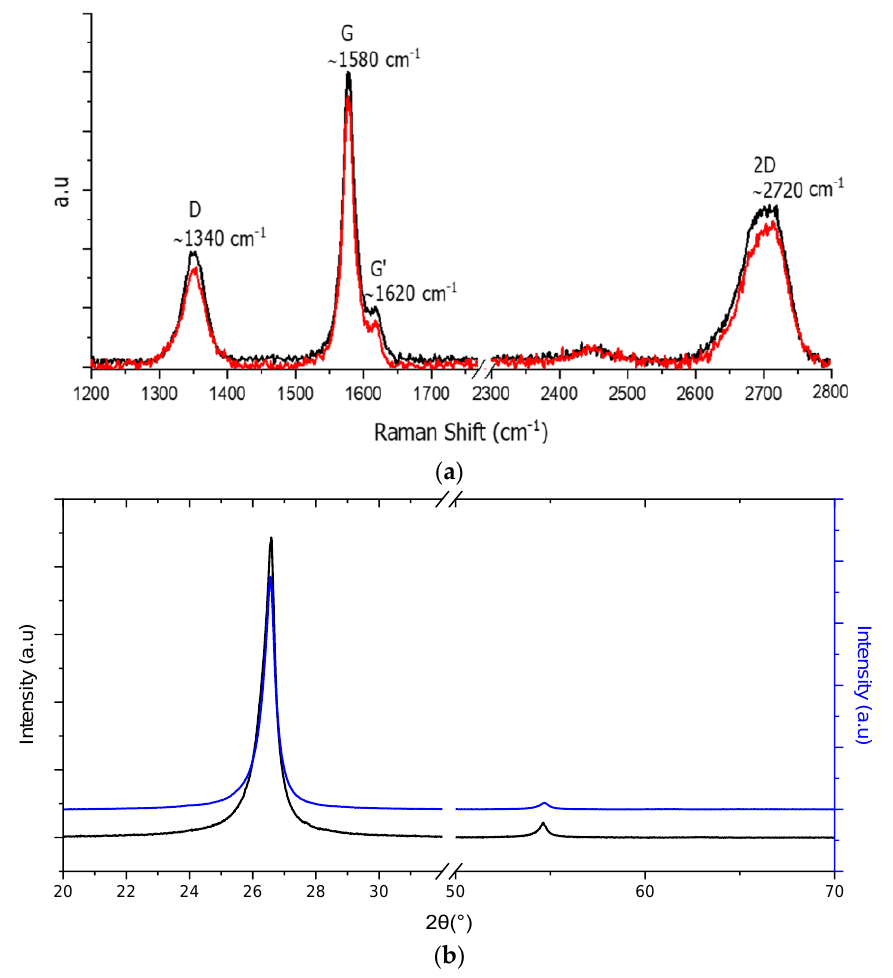
Figure 5. Raman spectra comparison of exfoliated graphene (black) and GEM (red) ( a ). XRD spectra of EG (black) and GEM (blue) ( b ).